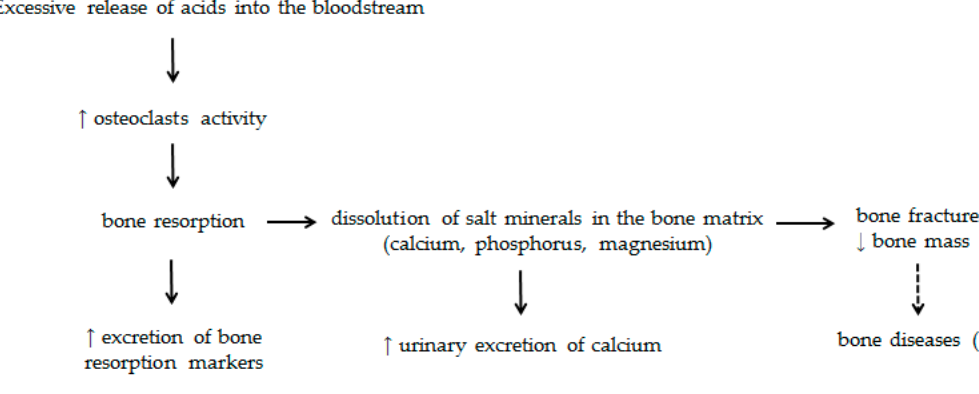
Figure 2. Schematic representation of the excessive release of acids into the bloodstream on bone tissue. The excess of acid release into the bloodstream, in detriment of the release of bases, may predispose to impaired bone metabolism, which involves the increased release of PTH with a consequent increase in osteoclasts activity and bone resorption, reducing the bone tissue mineralization. As a consequence, there may be an increased risk of bone fractures and bone mass reduction.